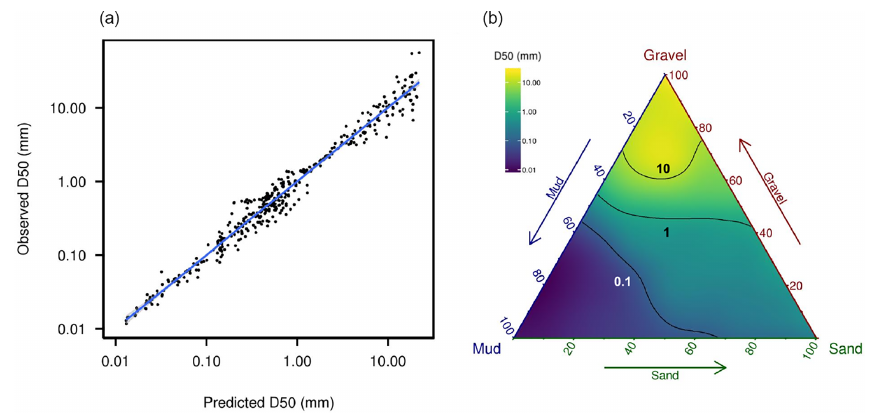
Figure 6. (a) Predictions of a GAM that relates whole-sediment D 50 to the mud, sand and gravel percentages. (b) Relationship between total sediment median grain size and percentage of mud, sand and gravel. The relationship was derived using a general additive model which relates the D 50 to the mud, sand and gravel percentage.